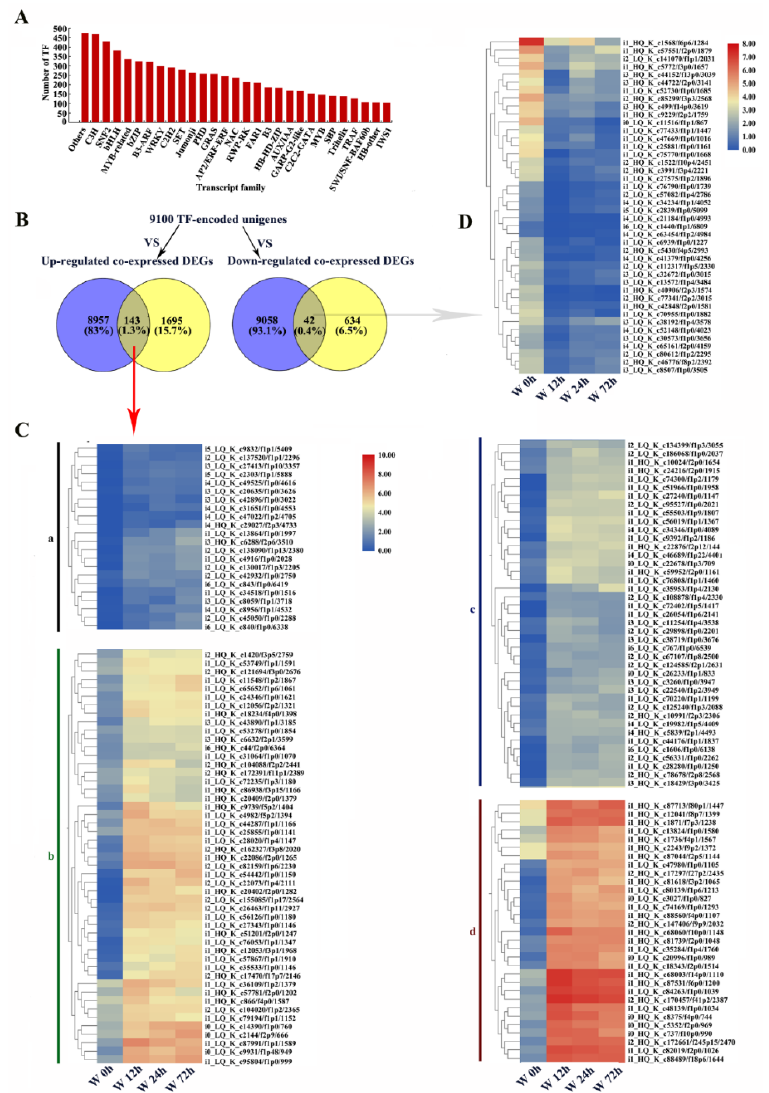
Figure 12. Identification of unigenes or DEGs encoding transcript factors (TF). ( A ) statistics of unigenes encoding TFs; ( B ) venn diagram of co-expressed DEGs and unigenes encoding TF; ( C ) a heatmap analysis of up-regulated co-expressed DEGs encoding TFs. According to expression patterns, these up-regulated co-expressed DEGs were clustered to 4 groups (a, b, c, d); ( D ) a heatmap analysis of down-regulated co-expressed DEGs encoding TFs. W, waterlogging.